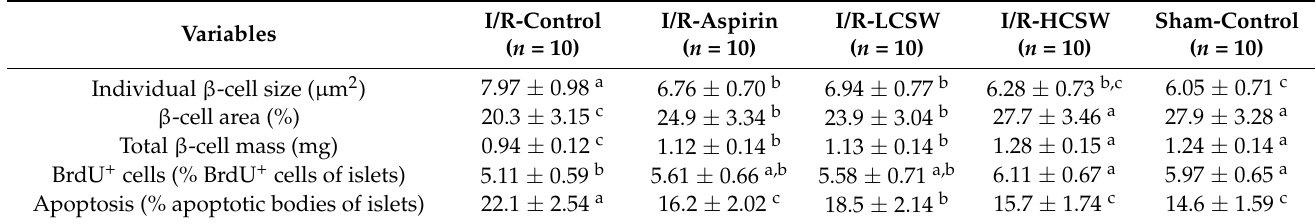
Table 3. Pancreatic β -cell mass.